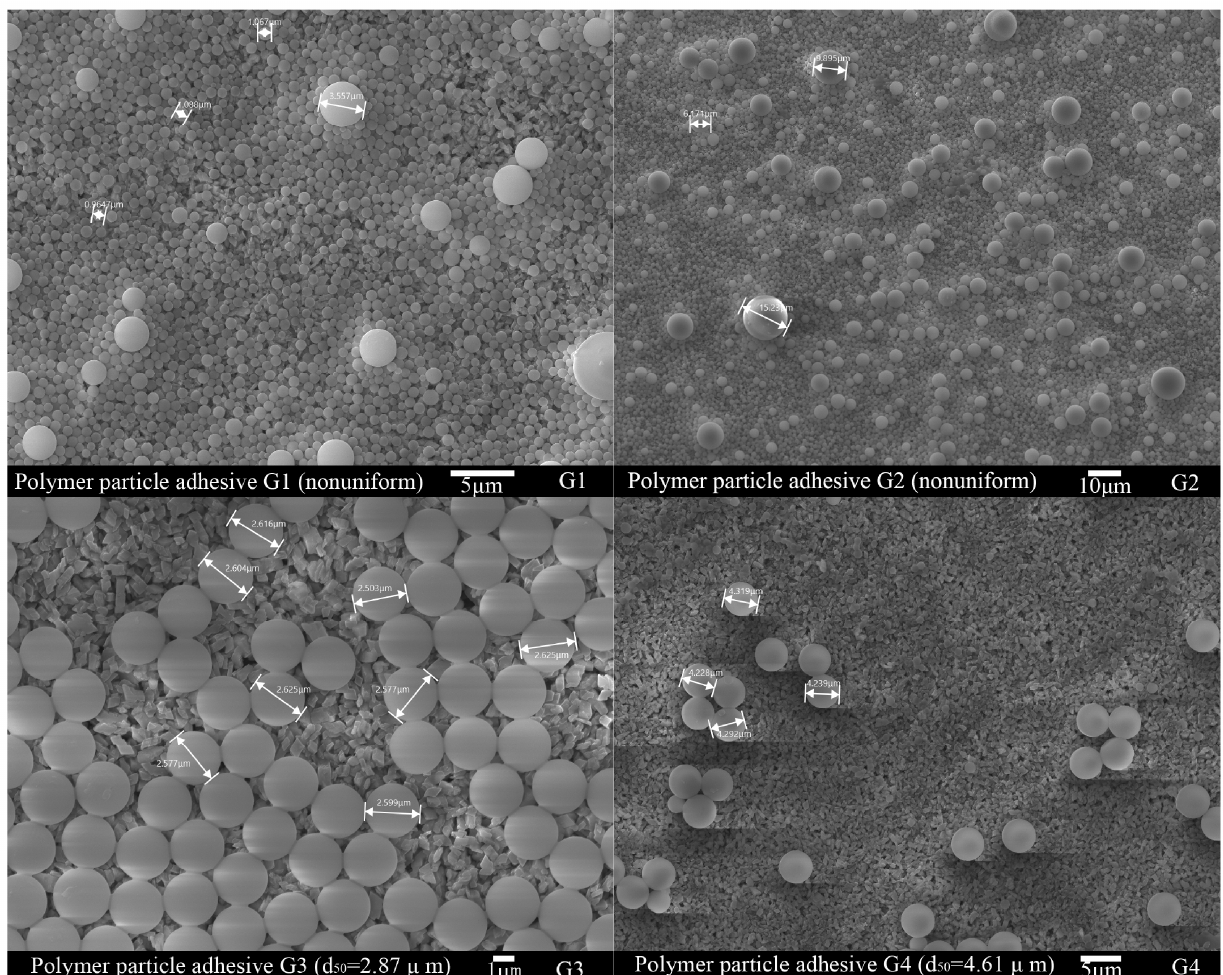
Figure 5. The SEM of the synthesized polymer particle adhesives (G1, G2, G3 and G4).